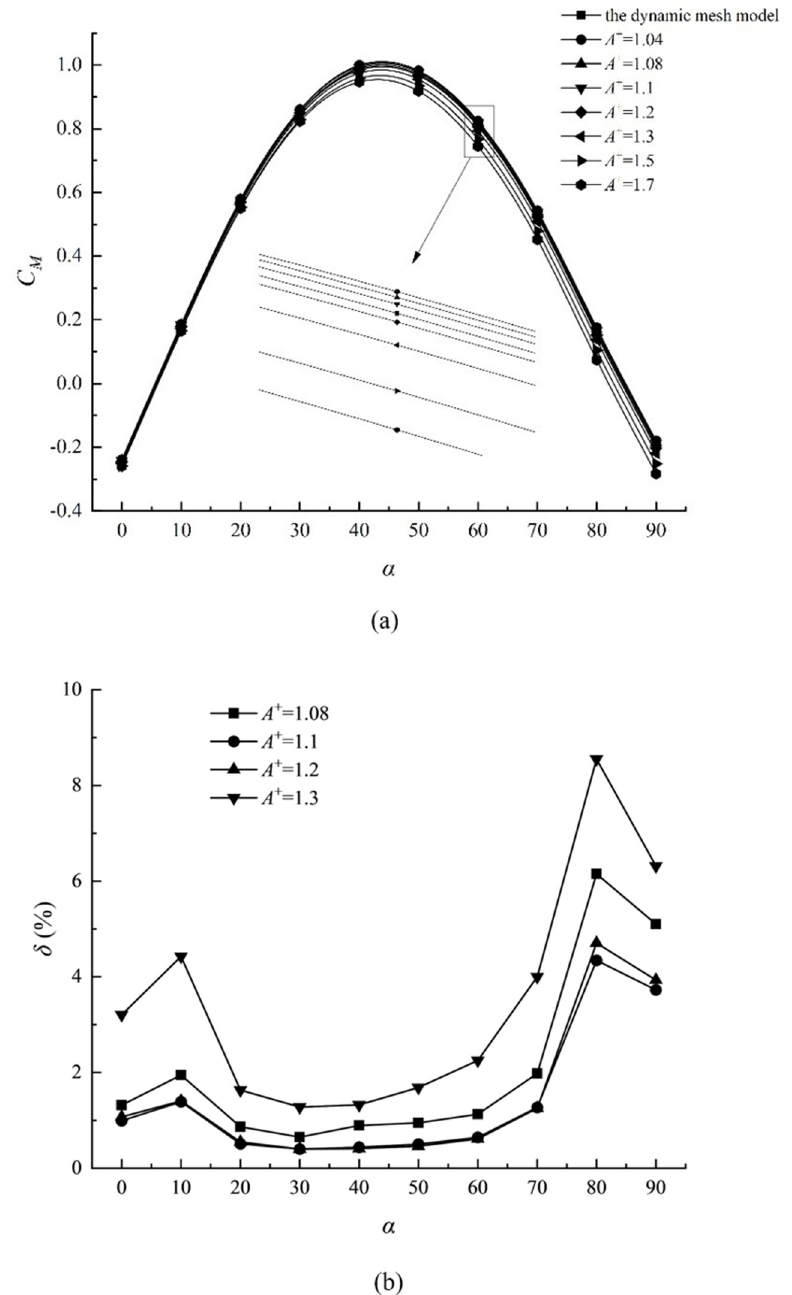
Fig 4. Torque distribution and relative deviation distribution under different rotation angles. (a) torque distribution and (b) relative deviation